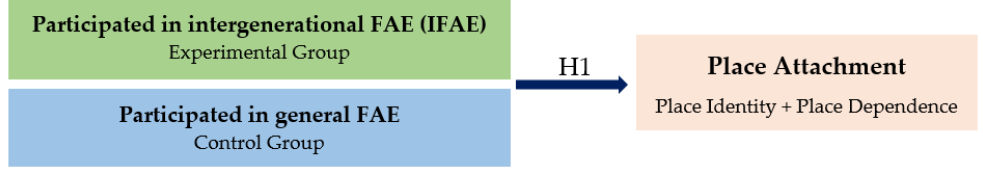
Figure 1. The study framework.